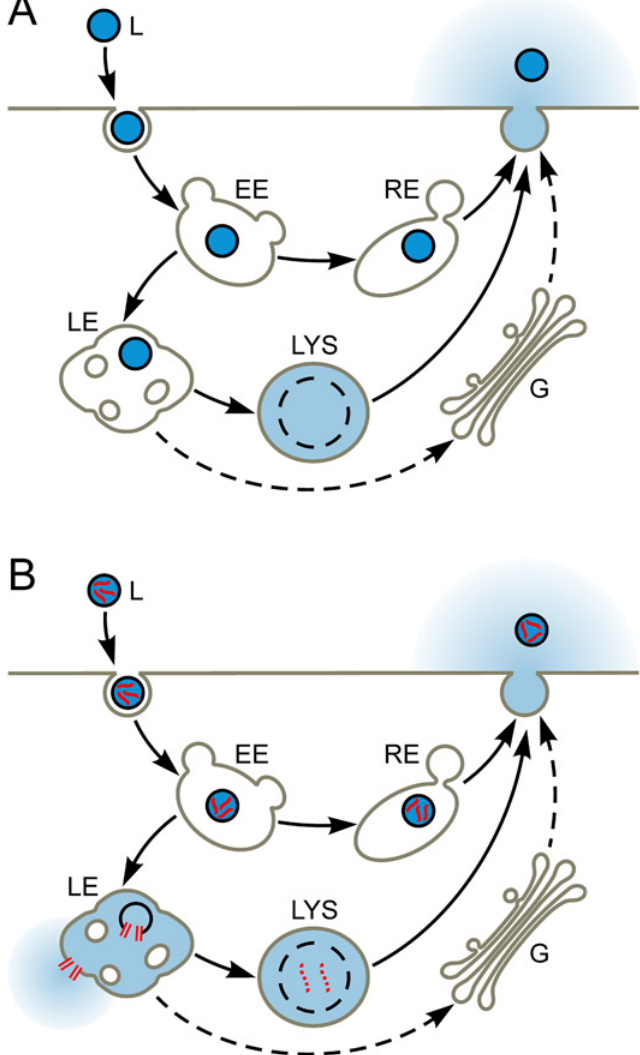
liposomal and endosomal membranes and thus facilitate release of liposomal contents into the